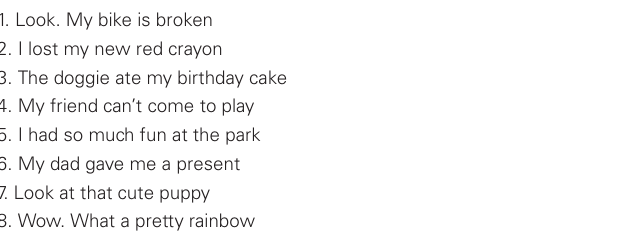
Table 2 | Sentences imitated by